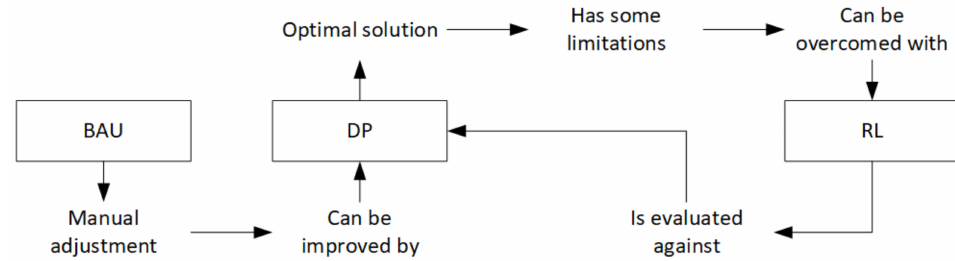
Figure 10. Models of cycle time adjustment and its connections considered in this